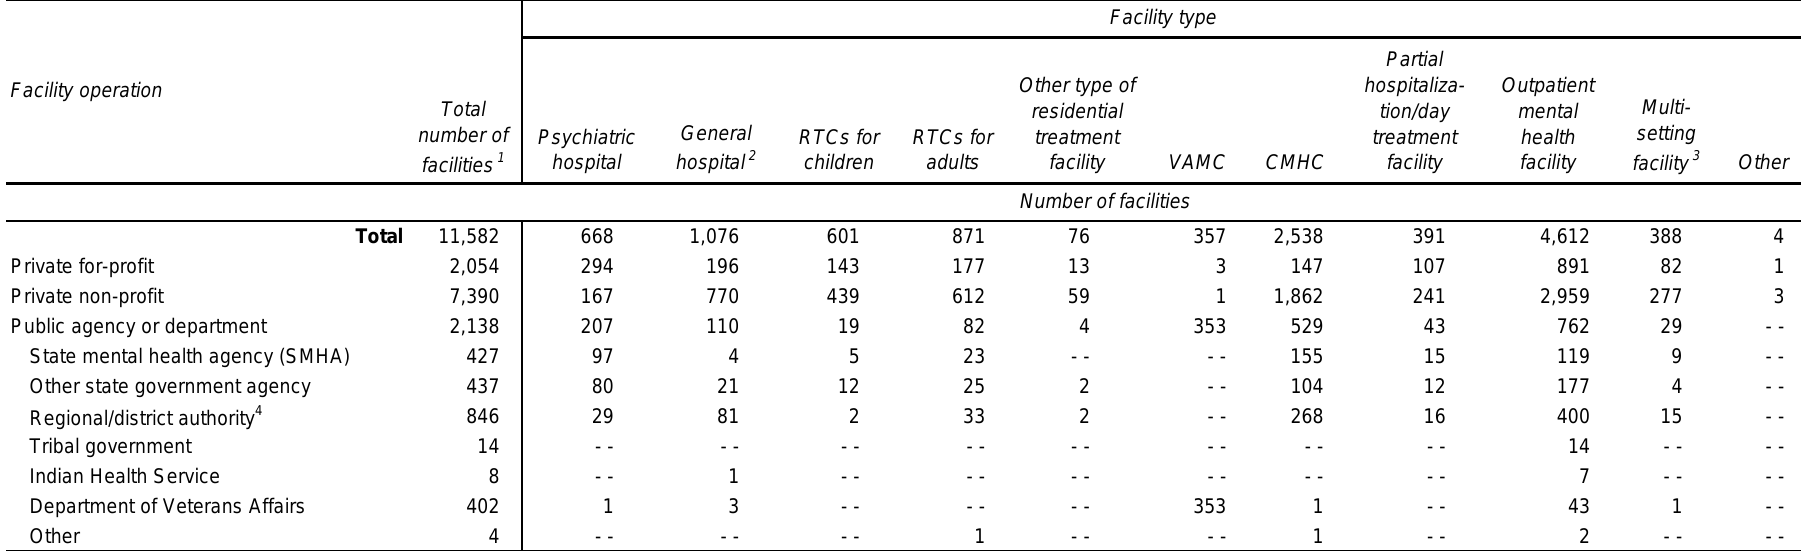
Table 2.2a. Mental health treatment facilities, by facility type and facility operation: Number,